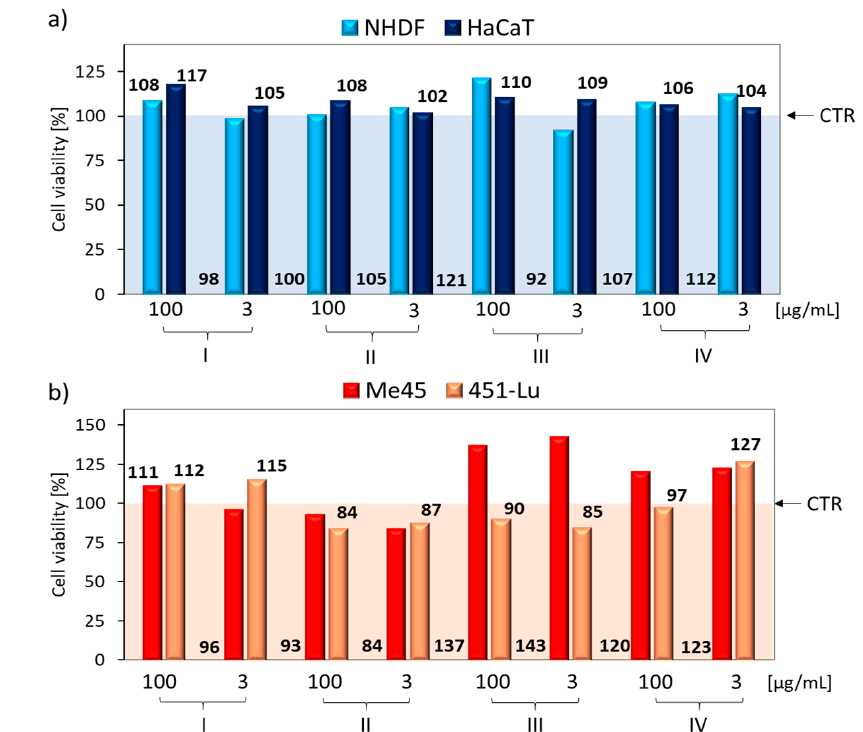
Figure 5. Comparison of in vitro cytotoxicity effects of carriers at higher (100 μ g/mL) and lower (3 μ g/mL) concentrations in exposure to ( a ) healthy cell lines, and ( b ) melanoma cell lines, where CTR—the control sample viability set to 100% as a baseline for cell viability calculations with the carrier.